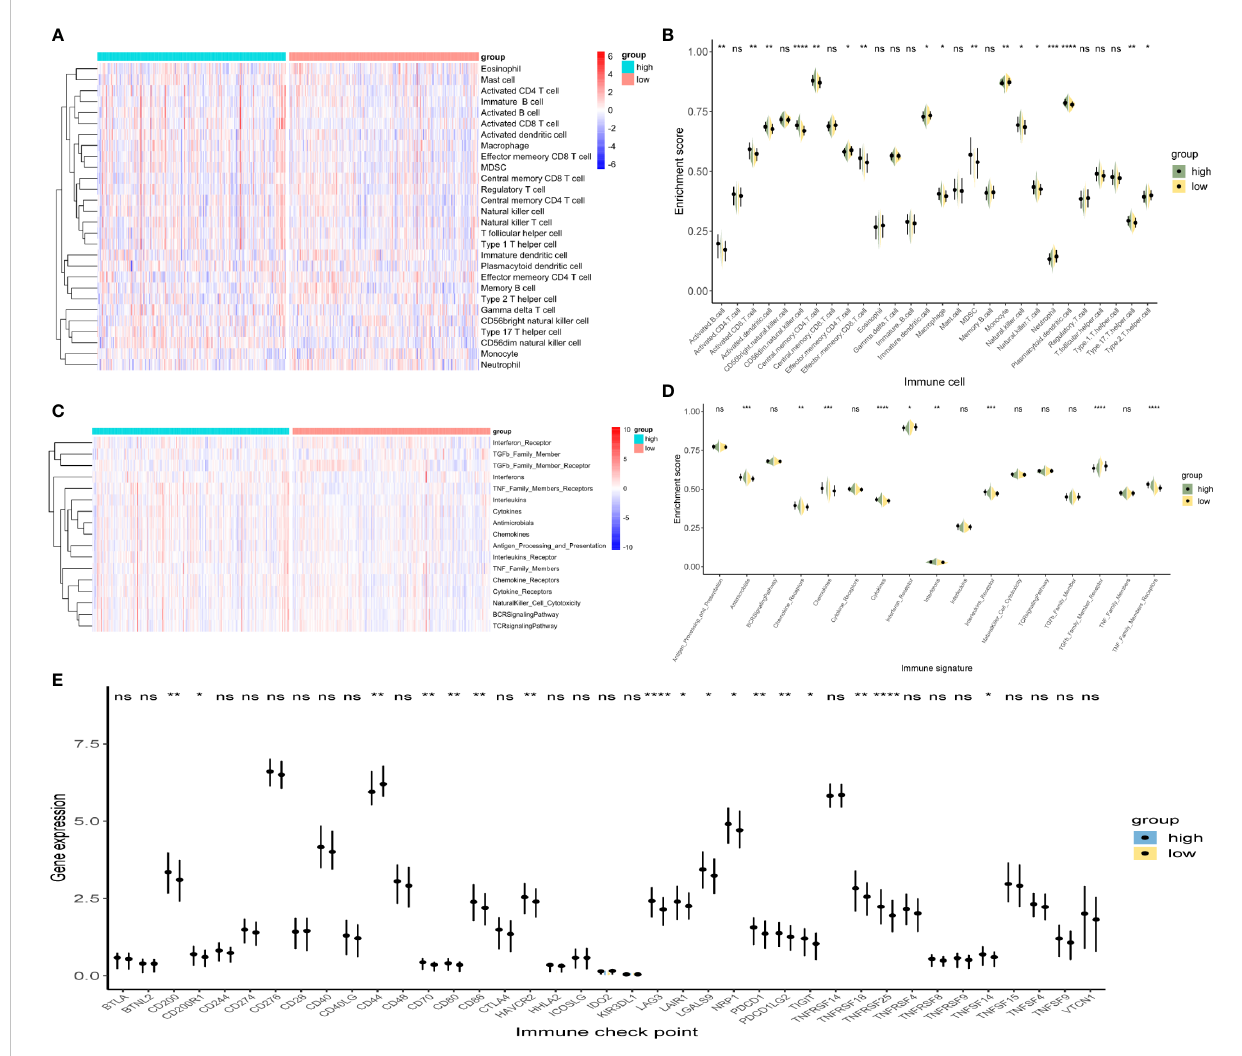
FIGURE 6 Immune in fi ltration analysis between the high- and low-risk groups. (A, B) Heat map and violin plot of 28 immune cells. (C, D) Heat map and violin plot resulting from the enrichment analysis of 17 immune-related signaling pathways. (E) Expression levels of immune checkpoints. *p < 0.05, **p < 0.01, ***p < 0.001, ****p < 0.0001, whereas ‘ ns ’ is non-signi fi